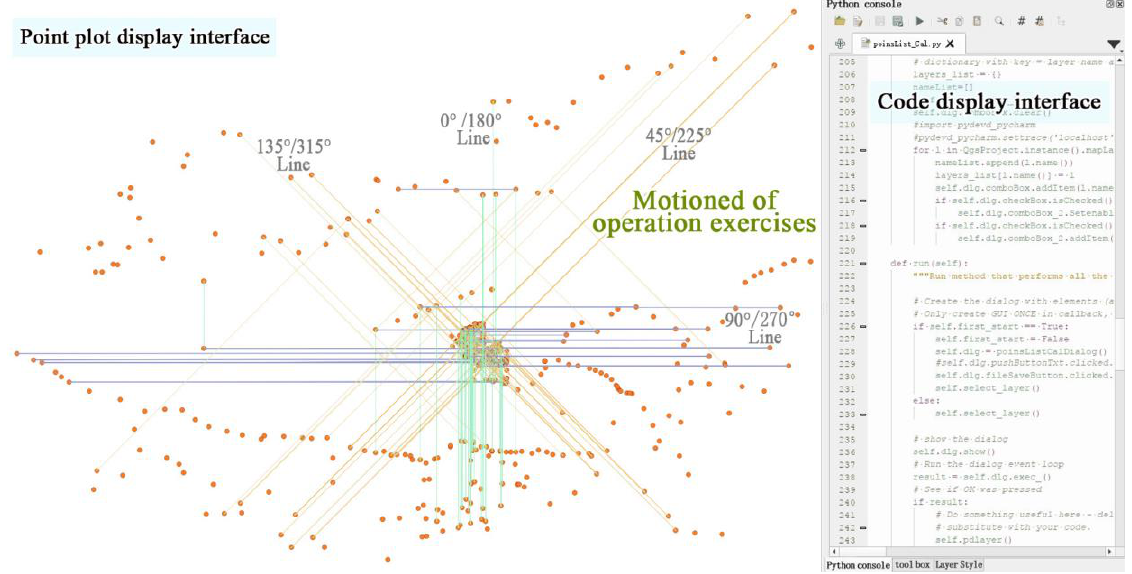
Figure 6. The redevelopment of the QGIS platform was carried out using Python to realize automatic decision making.